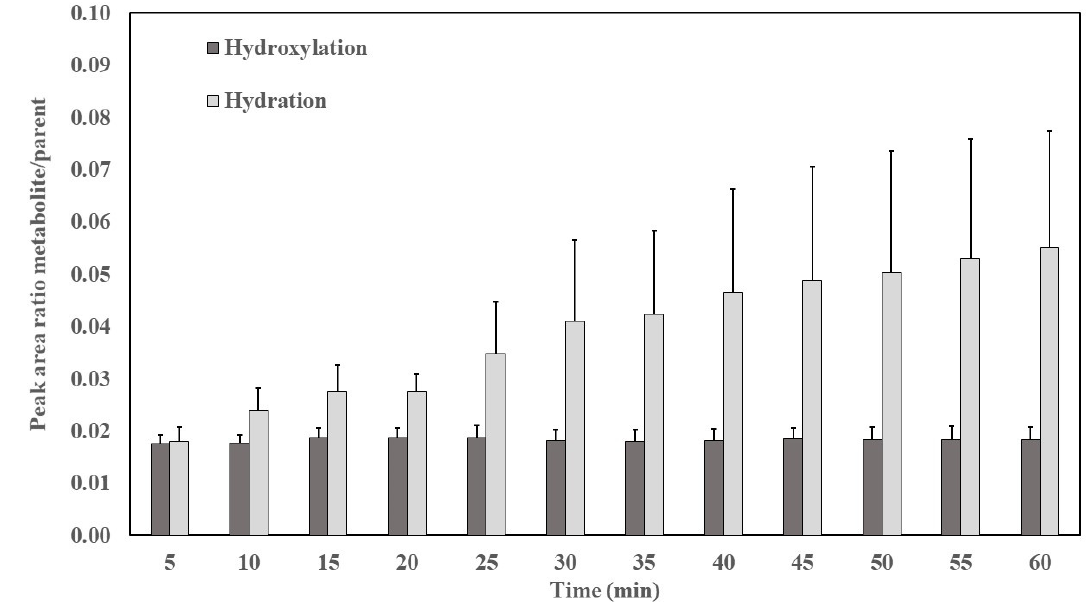
Figure 2. Peak area ratio metabolite/oleocanthal (OLC) as a function of time in lumen. Results are expressed as the mean ± standard deviation.